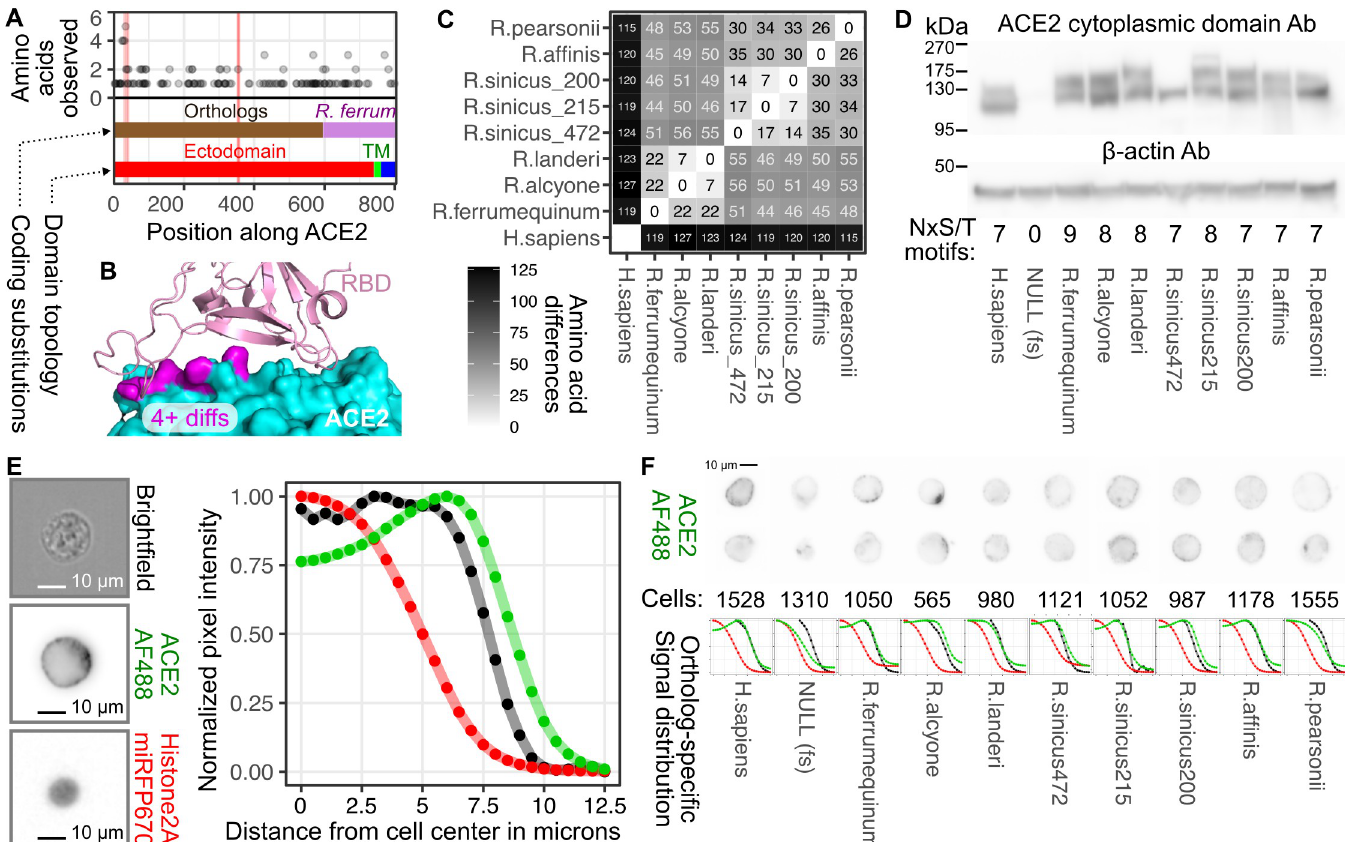
Fig 4. Diversity in ACE2 protein sequences. (A) ACE2 positions with the greatest number of amino acid differences among horseshoe bats. The red vertical lines denote the 2 segments of ACE2 linear sequence involved in its interaction with SARS-CoV and SARS-CoV-2 RBDs: positions 31 through 41 for the first patch, and 353 through 357 for the second. The ACE2 coding regions from the panel of horseshoe bats are shown in dark brown, while the C-terminal portion common to all Rhinolophus ACE2 constructs is colored purple. The ectodomain, transmembrane, and cytoplasmic domains are colored in red, green, and blue, respectively. (B) Positions with 4 or more different amino acids observed across rhinolophid ACE2 proteins as seen in panel A are shown in magenta in a structure of SARS-CoV-2 RBD bound to human ACE2 (PDB: 6m17). (C) Hamming distance matrix showing the number of nonidentical amino acids between pairs of tested ACE2 chimeric proteins. (D) Representative immunoblotting of the total steady-state abundance of each chimeric ACE2 protein stably expressed, alongside a 2A-linked open reading frame encoding human TMPRSS2, in HEK 293T landing pad cells. An antibody raised against the human ACE2 cytoplasmic sequences, but also cross-reactive with the sequence present in R . ferrumequinum , was used in the top panel. An antibody that recognizes human beta-actin was used in the bottom panel. The number of potential N-glycosylation motifs in each sequence are shown at the bottom. (E) Representative image of ACE2 surface expression, marked by Alexa-Fluor 488, on an ACE2-expressing cell, from an Amnis Image Stream flow cytometer, compared to brightfield and iRFP670 fluorescence (left) and a plot showing the signal intensities of all 3 at incremental distances from the center of the cell (right). (F) Two representative images of ACE2 staining for various Rhinolophus bat ACE2 orthologs (top) and plots of ACE2, brightfield, and nuclear marker signals compared to distance from the cell center (bottom). The scale bar denoting 10 μ m distance shown in the top-left image applies to all image panels in this figure. The underlying data can be found in S2 Data, and the source code can be found at https://github.com/MatreyekLab/ACE2_dependence. ACE2, angiotensin converting enzyme-2; RBD, receptor binding domain; SARS-CoV, Severe Acute Respiratory Syndrome-related Coronavirus; SARS-CoV-2, Severe Acute Respiratory Syndrome-related Coronavirus 2. ( Fig 5A ). In the process of performing these experiments, we observed massive syncytia for-